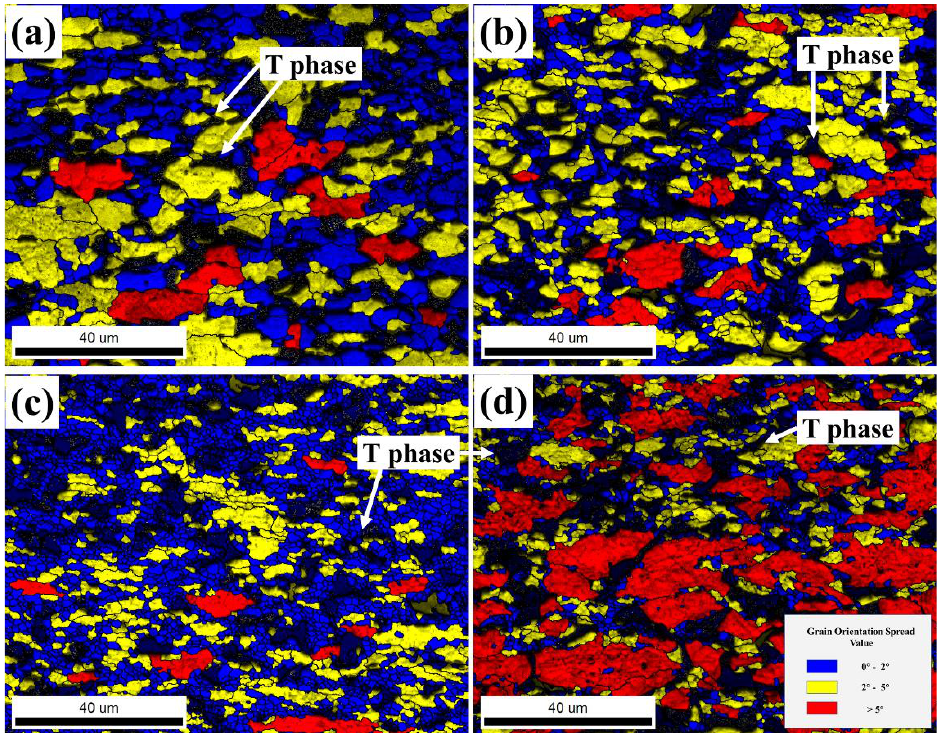
Figure 10. Recrystallized volume fraction and recrystallized grain size at different deformation temperatures.